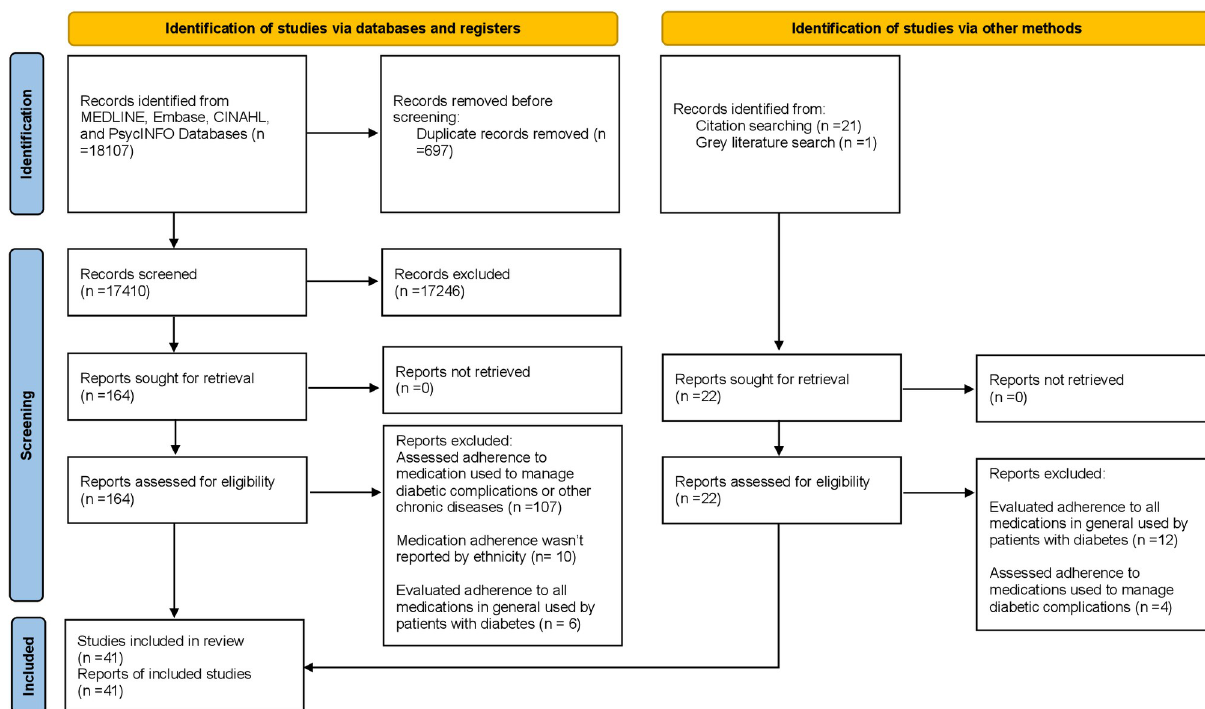
Fig 1. PRISMA flow diagram of included